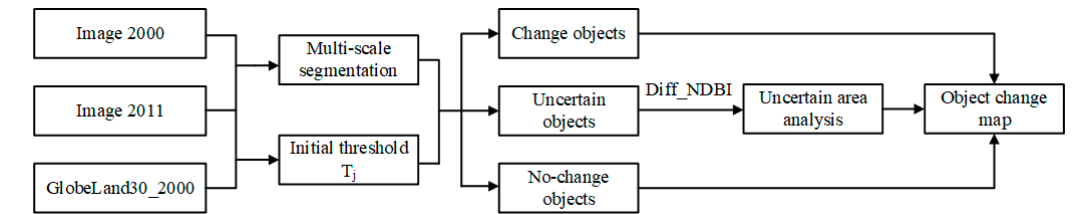
Figure 3. Flowchart of object-based extended change vector analysis method (ECVA_OB) method. The ECVA_OB method has two main